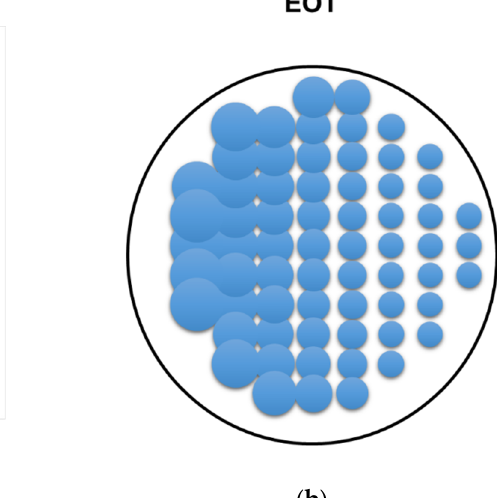
4 of 16 Figure 3. Schematic of MIS capacitor with slant etch for SiO 2 . Corresponding oxide charge densi- ties are indicated.